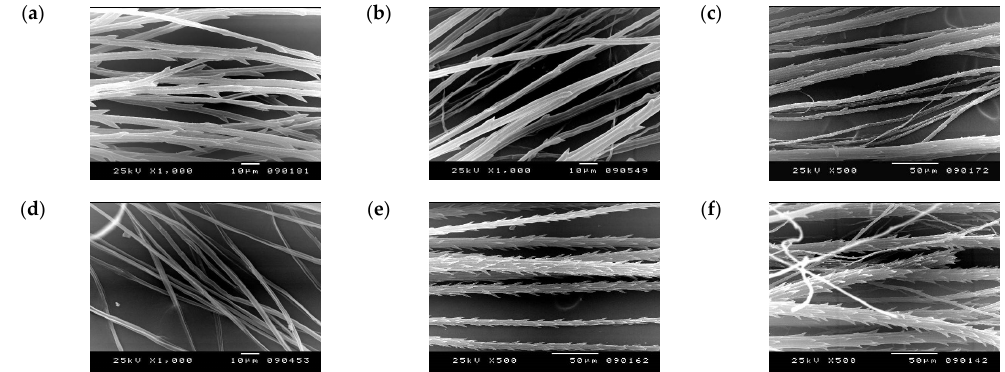
Figure 7. SEM micrographs of pappus type, protuberance density in 150 µm and orientation. ( a ) subhomomorphic setaceous bristles, sparsely, appressed in L. spinosa ; ( b ) dimorphic, sparsely, appressed in L. massauensis ; ( c ) dimorphic, moderate, appressed in L. nudicaulis (group 7); ( d ) homomorphic of cottony rays, bristles absent in L. angustifolia subsp. arabica ; ( e , f ), high, inclined in L. mucronata : ( e ), subhomomorphic setaceous bristles in L. mucronata subsp. cassiniana , ( f ), dimorphic in L. mucronata subsp. mucronata